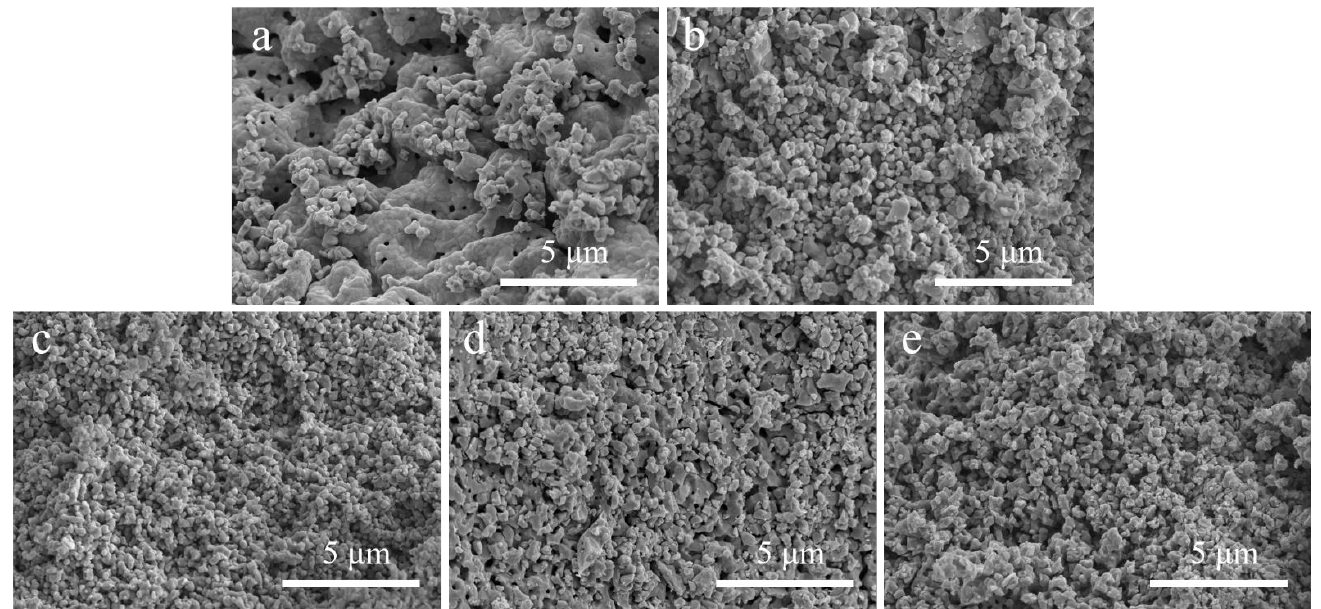
Figure 2. SEM images of fresh LMO ( a ), 0.1LCMO ( b ), 0.2LCMO ( c ), 0.3LCMO ( d ), 0.4LCMO ( e ).